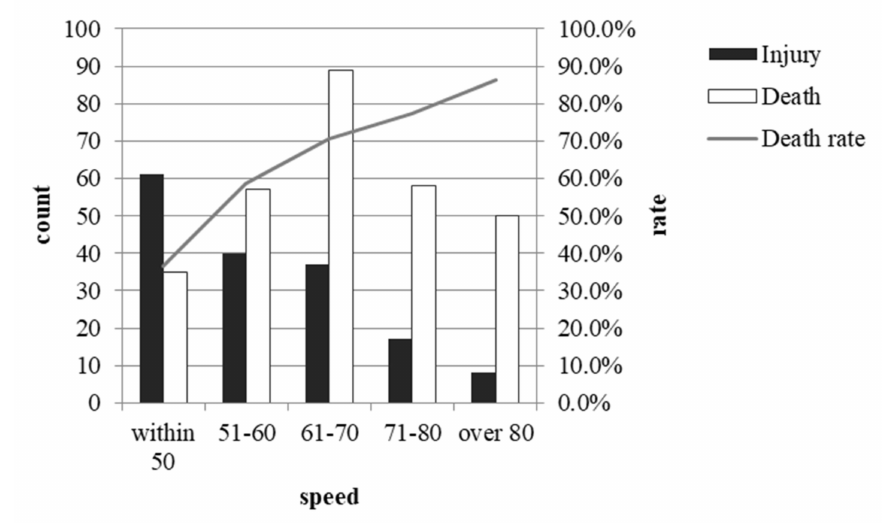
Figure 10. Frequency of different collision severities with different